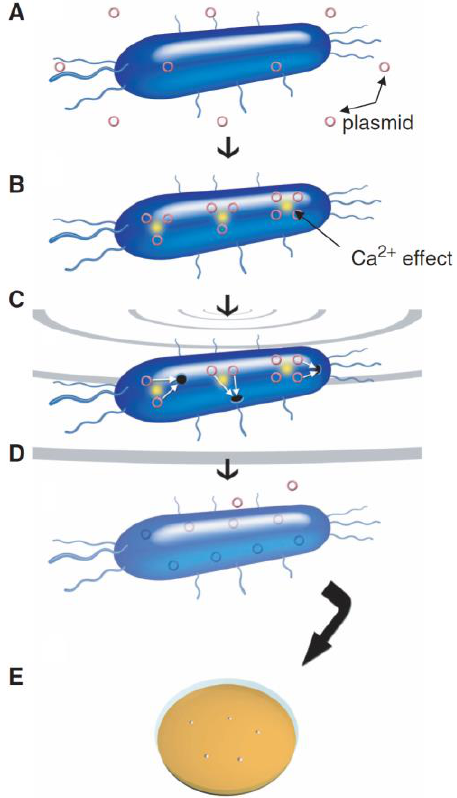
Figure 1. Illustration of proposed mechanism of ultrasound DNA transfer [10]. ( A ) A bacterial cell and plasmid DNA are suspended in an aqueous solution. ( B ) 50 mM CaCl 2 promotes transformation. ( C ) Ultrasound generates pores in cell membranes through which plasmids enter the cell. ( D ) Pores are closed and plasmids are retained in the cell. ( E ) Bacteria acquire new functions after taking up plasmid DNA.